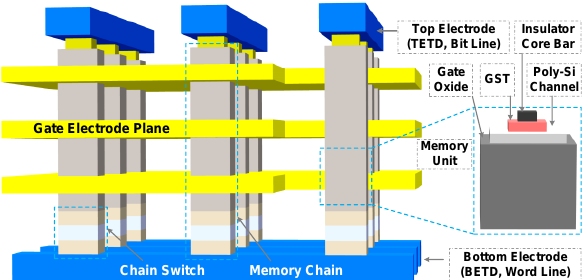
Figure 1. Schematic of a conventional 3-D vertical PCM array.